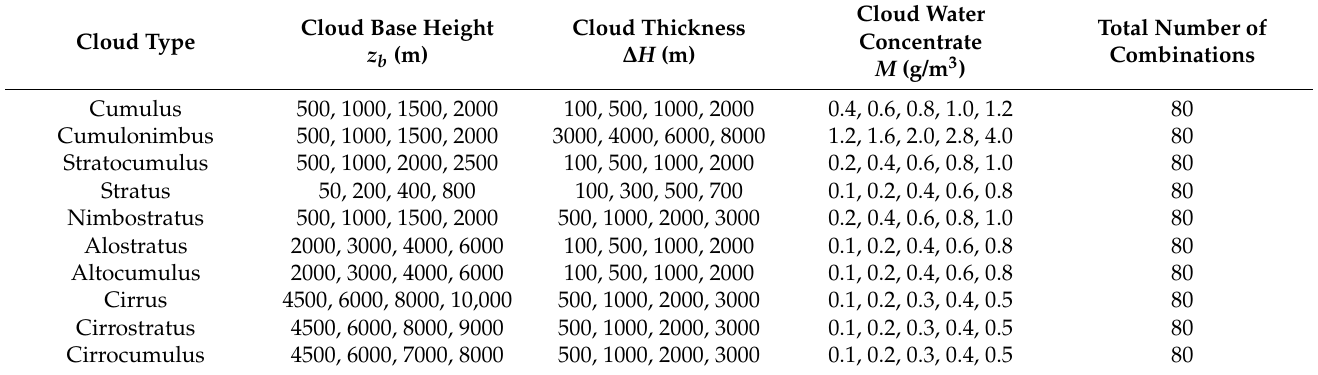
Table 2. The 800 possible combinations of cloud parameter values based on the